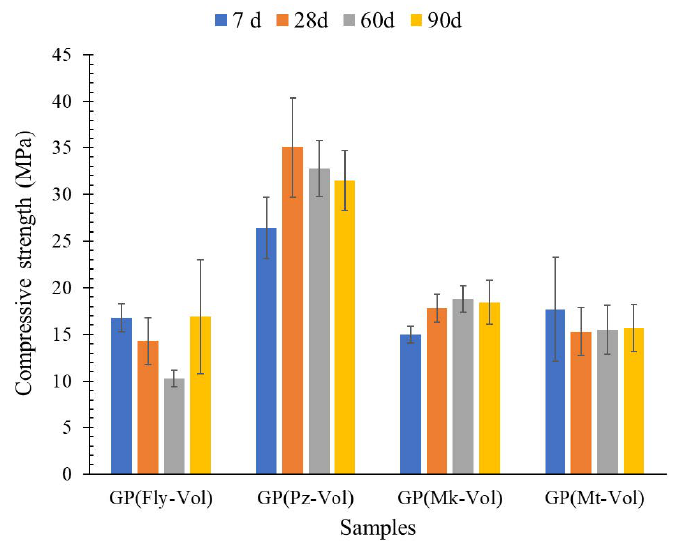
Figure 4. Compression strength of GP(Fly-Vol), GP(Pz-Vol), GP(Mk-Vol), and GP(Mt-Vol) geopolymers at 7, 28, 60, and 90 days of curing.